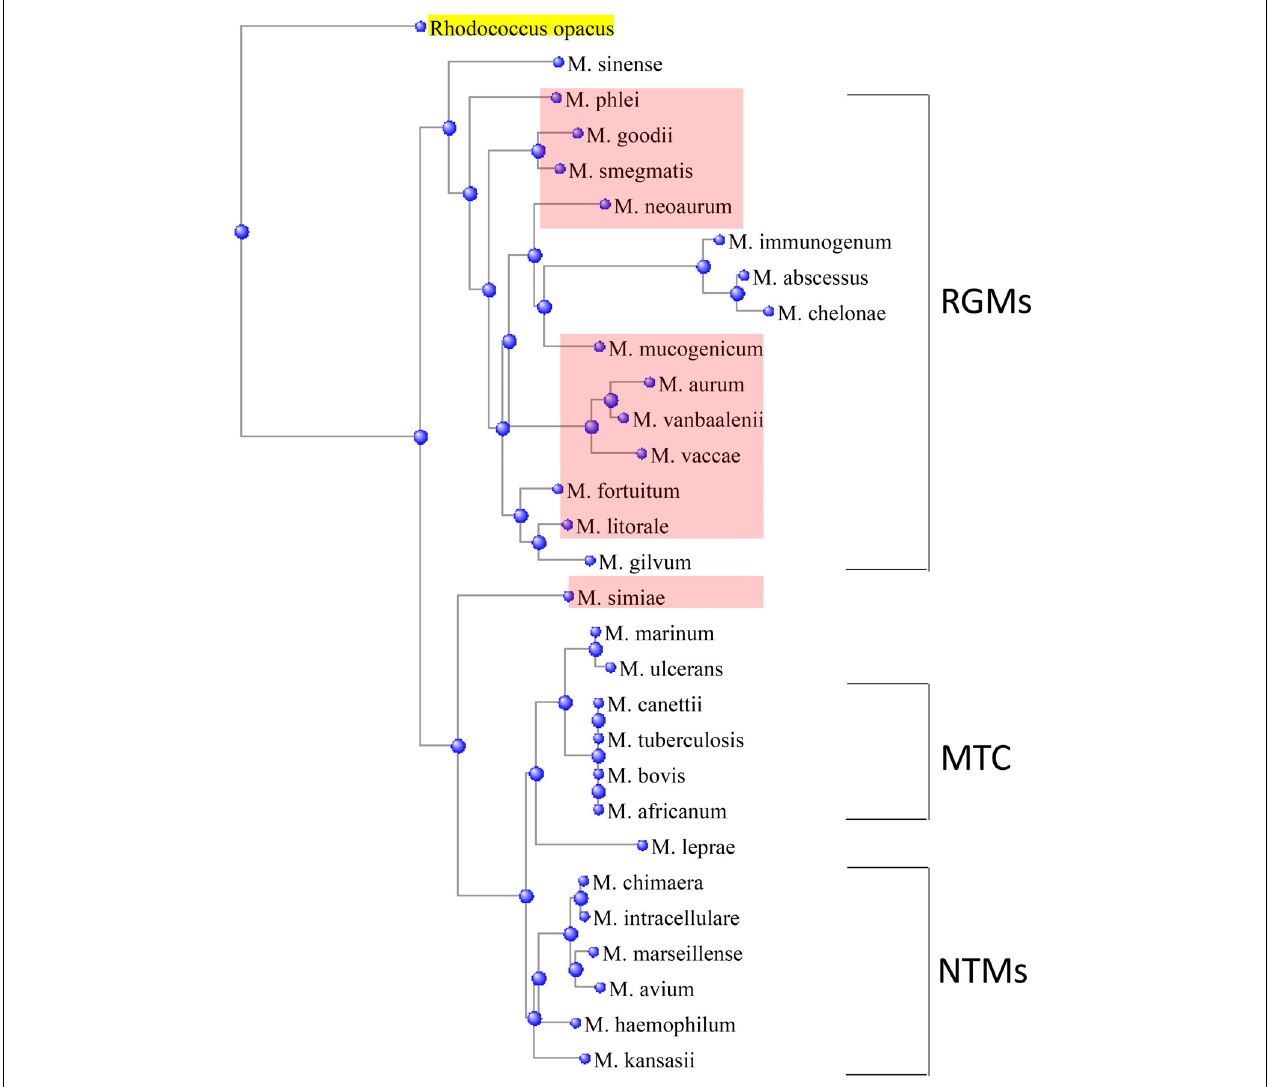
FIGURE 7 | Presence of gpr locus in a subset (shaded pink) of rapidly growing mycobacteria (RGMs), which are depicted in relationship to the other RGMs, slow-growing non-tuberculous mycobacteria (NTMs), and Mycobacterium tuberculosis complex (MTC), based on their similarities in 16S rRNA sequences. A member of NTM, Mycobacterium simiae, is an outlier. The phylogenetic tree was constructed by distance method using Rhodococcus opacus as an outgroup.